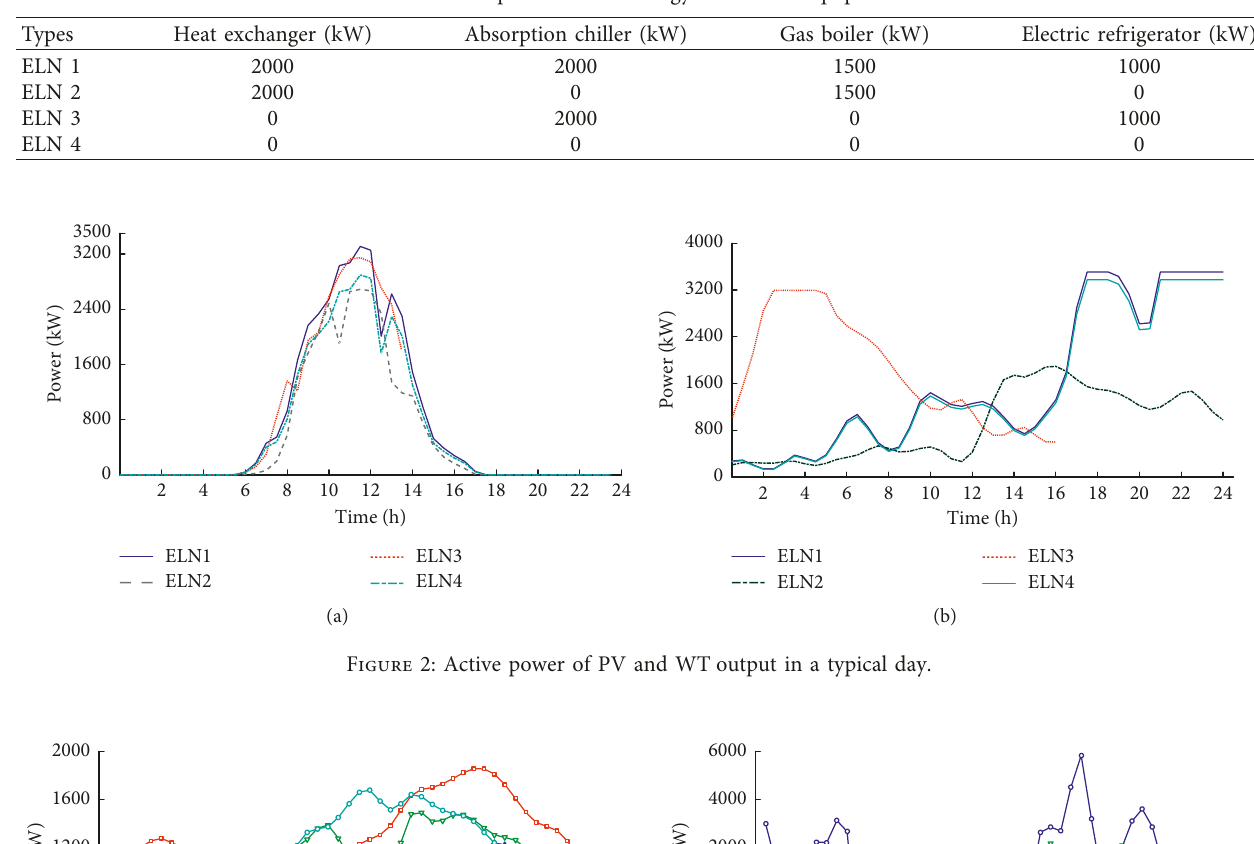
Table 2: The parameters of energy conversion equipment.